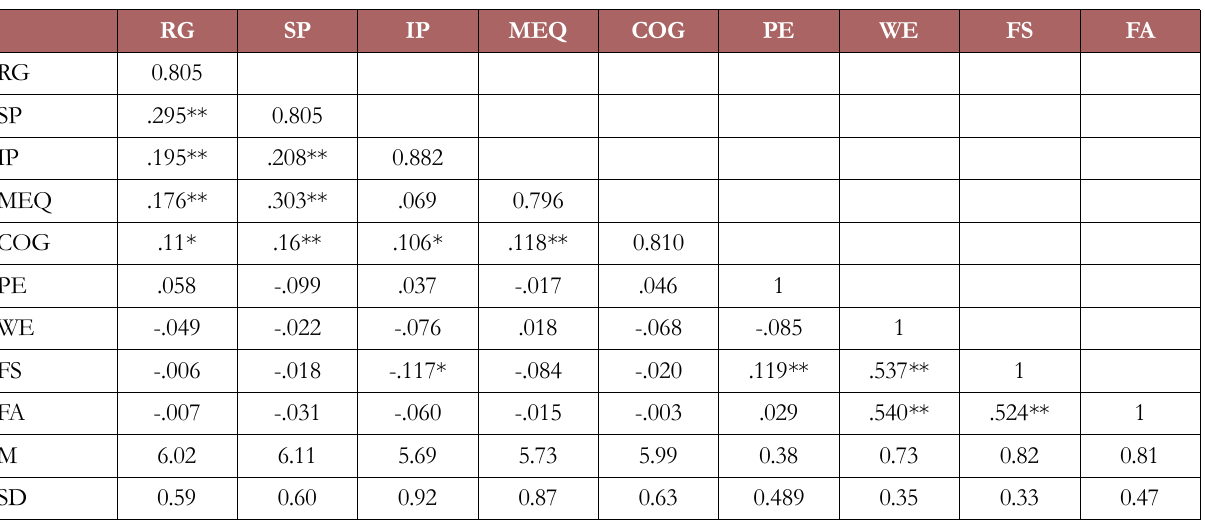
Table 1. Mean, Standard deviation and results of discriminant